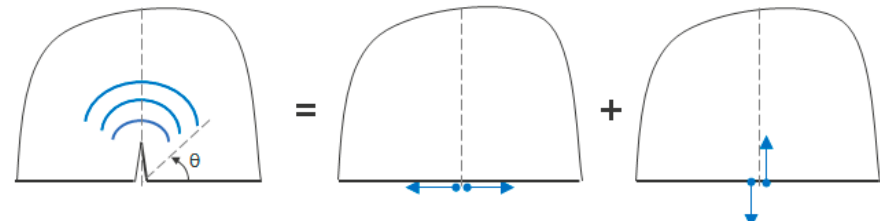
Figure 15. Scattered wave field representation due to the contribution of force doublets associated with the Mode I and Mode II crack opening displacements.